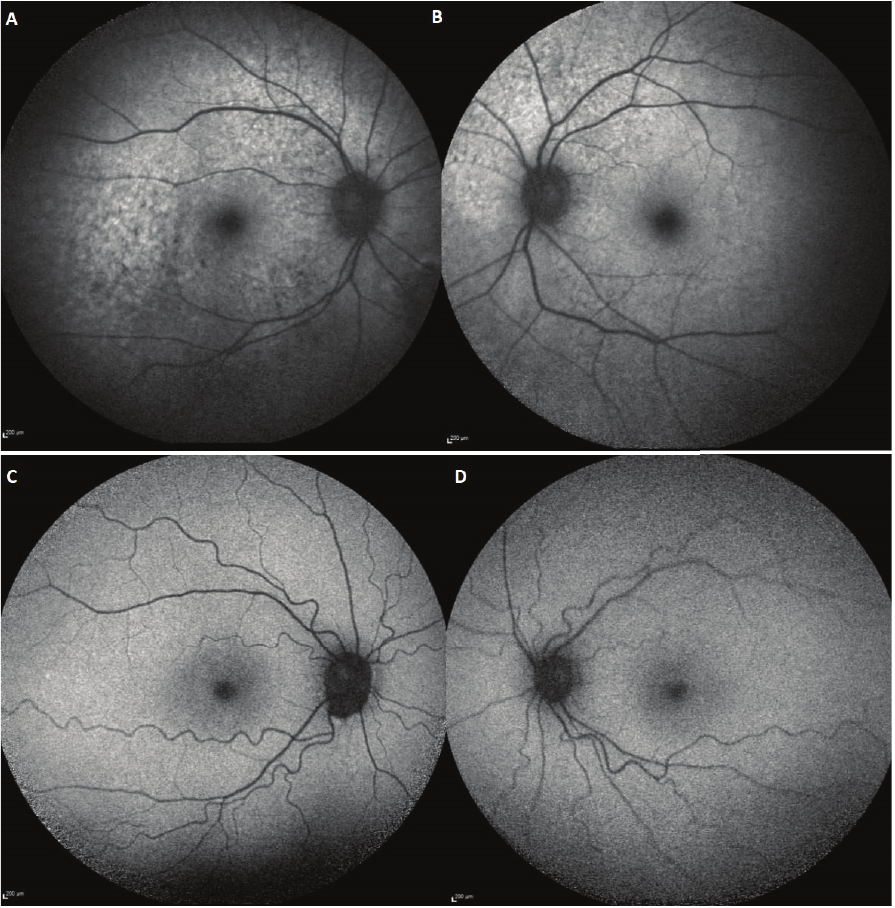
Figure 2. Blue autofluorence (BAF) of the right (A) and left (B) eyes of patient 1 which demonstrates hypo-autofluorescence around the arcades, around the optic nerve, and in macula of both eyes. BAF of the right (C) and Left (D) eyes of patient 2 does not show any changes in both